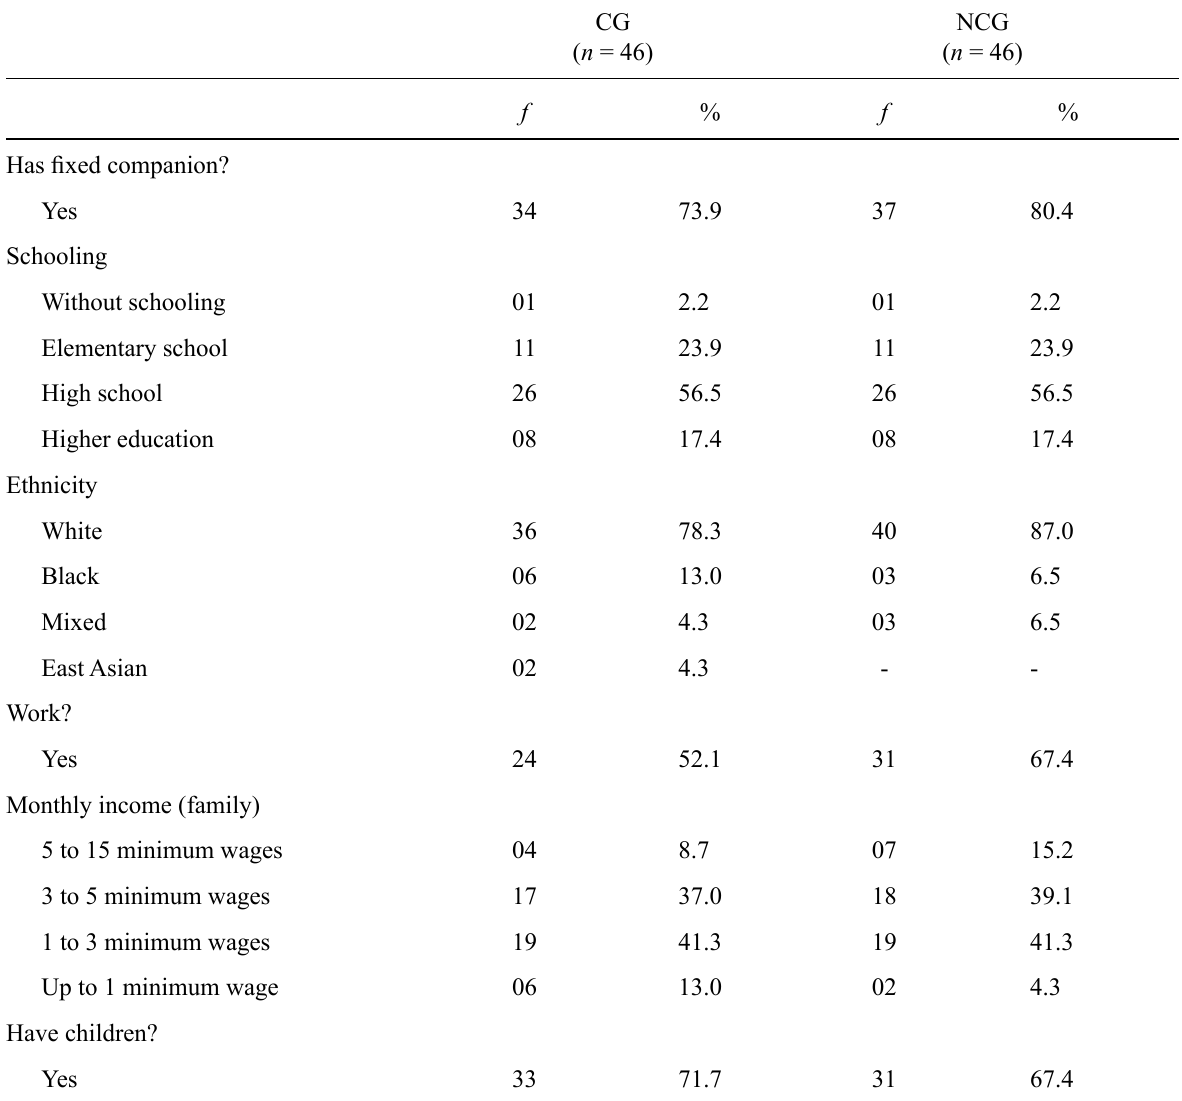
Distribution of Demographic Variables among the Participants, according to the Groups – CG (clinical group) and NCG (non-clinical